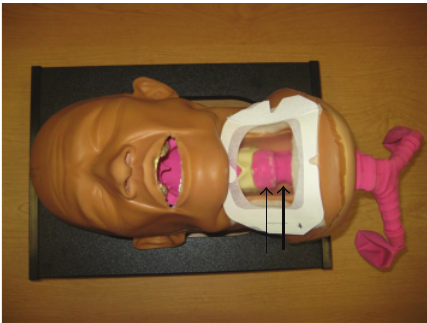
Figure 1: The thin arrow points to the cricothyroid membrane. The bold arrow points to the cricotracheal membrane.